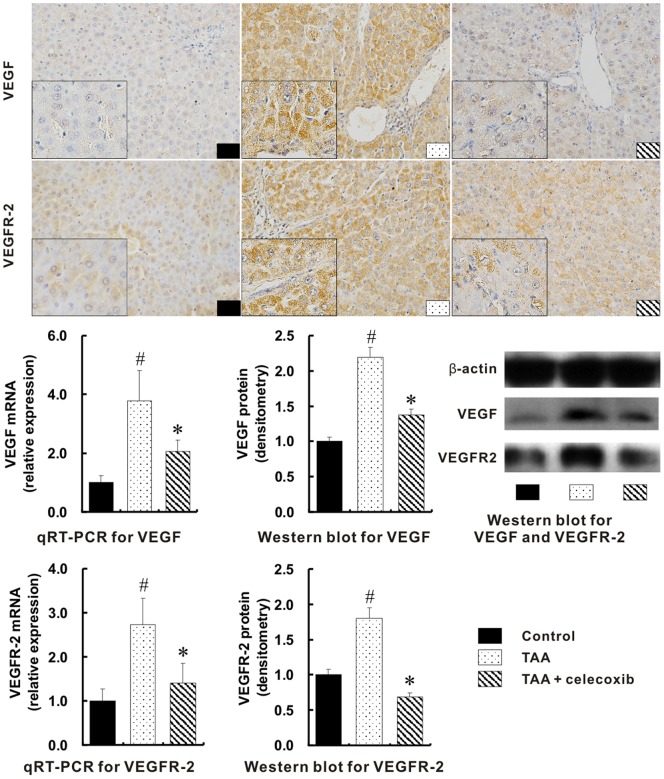
Suppression of angiogenetic factors by celecoxib treatment.Much more positive expressions for VEGF and VEGFR-2 were visualized in TAA group (1st - 2nd panels, Immunohistochemical stain, ×400 magnifications; inserts, ×1000 magnifications). The mRNA and protein levels of hepatic VEGF and VEGFR-2 in TAA group measured with qRT-PCR and Western blot respectively were the highest among three groups. # p<0.01 vs. control group; * p<0.01 vs. TAA group.